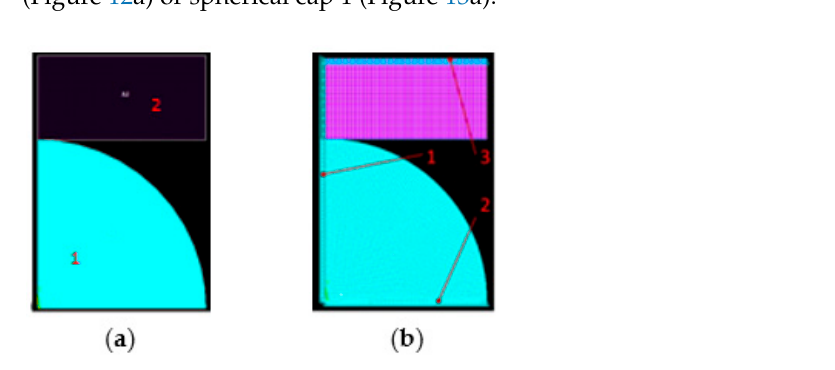
Figure 12. ( a ) Model composed of polyoxymethylene hemisphere 1 mated with moving rigid cylinder 2; ( b ) Mesh of finite elements and boundary conditions.